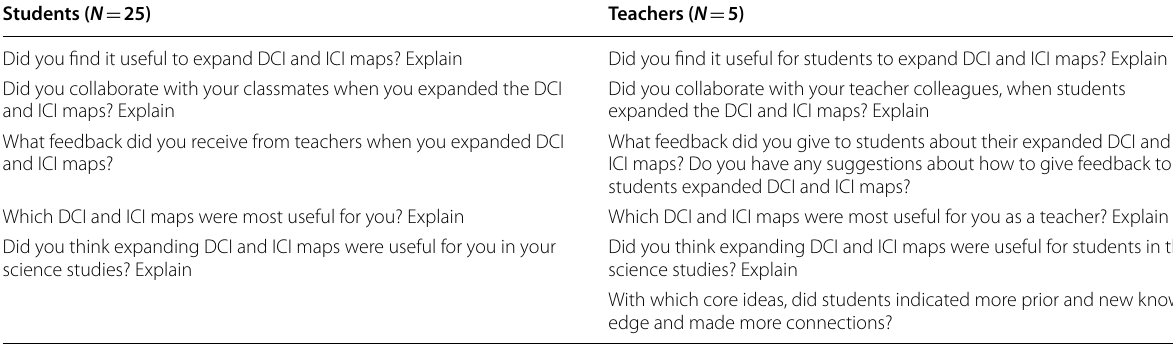
Table 3 The key interview questions related to teachers and students’ perceptions of the implemented DCI and ICI maps for promoting students’